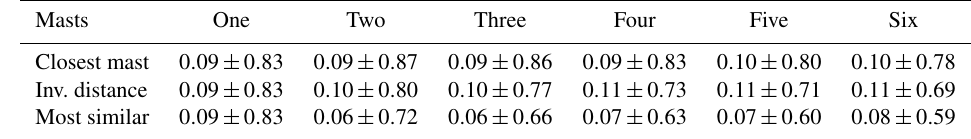
Table A2. Power density error (mean and standard deviation) depending on the number of predictor masts and selected strategies. Masts One Two Three Four Five Six Closest mast 46 ± 194 55 ± 208 55 ± 206 55 ± 199 55 ± 193 56 ± 189 Inv. distance 46 ± 194 56 ± 188 58 ± 181 58 ± 74 58 ± 168 57 ± 164 Most similar 46 ± 194 40 ± 165 38 ± 148 39 ±